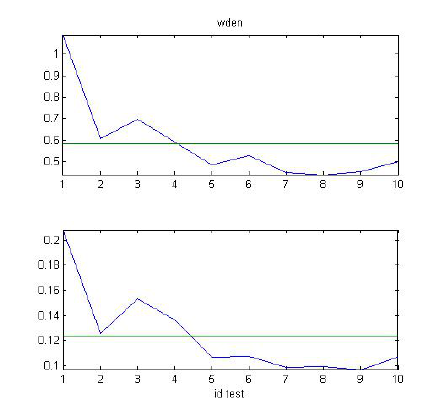
Figure 17. Descending slope, M = 0.06, most significant noise. Top - original signal and sig- nal denoised with wden Bottom – di ff erence be- tween original signal and signal denoised with wden.